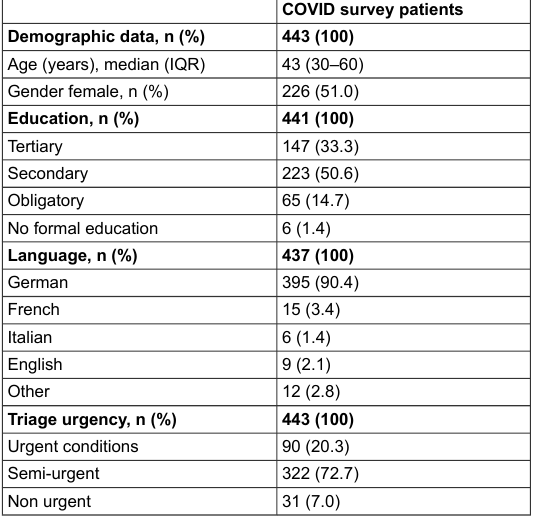
Table 2: Comparison of patients with and without telehealth use in COVID survey.